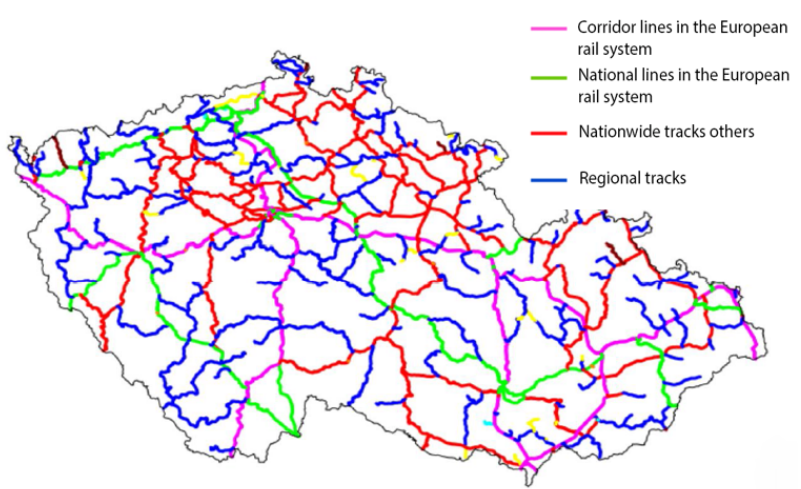
Figure 1. Railway line structure in the Czech Republic.